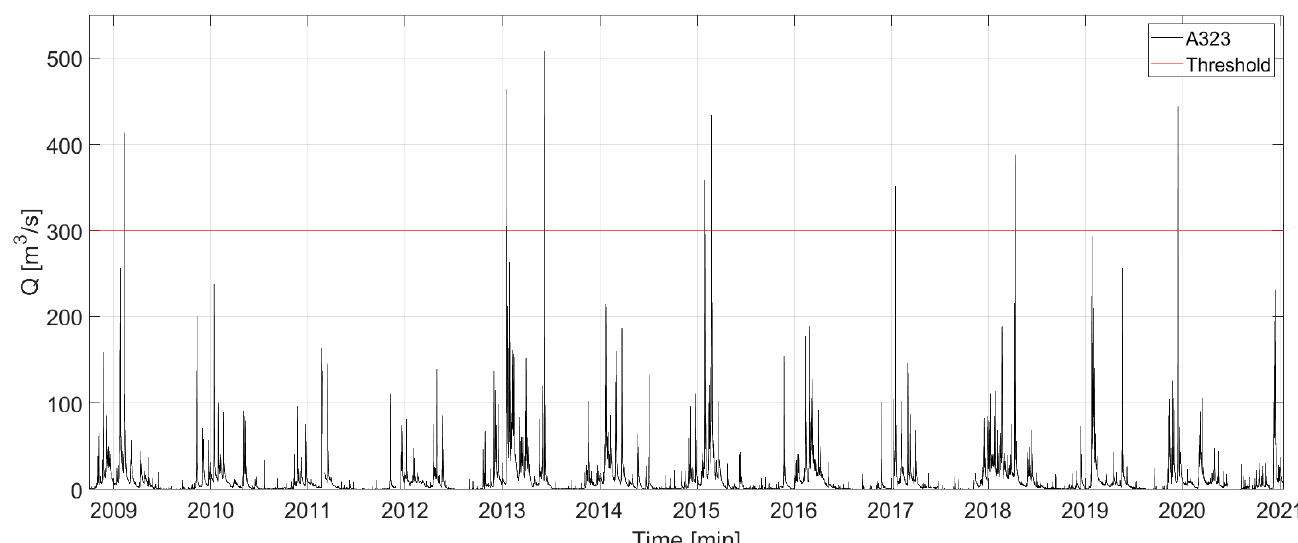
Figure 3. Floods selected in the A323 hydrometer by using a peak-over-threshold (POT) analysis with a threshold of 300 m 3 /s. Table 3. Hydraulic characteristics of the soil classes belonging to the soil